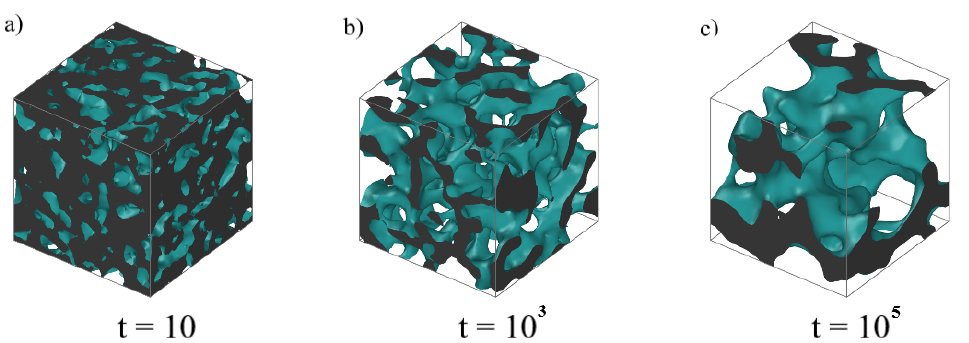
Figure 1. Morphologies obtained by letting the system age up to a time t (LJ units) after a quench at T = 0.1, ρ = 0.6, ( a ) t = 10, ( b ) t = 10 3 , ( c ) t = 10 5 . To ease the visualization, a surface mesh was constructed using OVITO [14]. The green region represents the surface of the glassy phase. The gray region represents the inside of the dense phase sliced at the